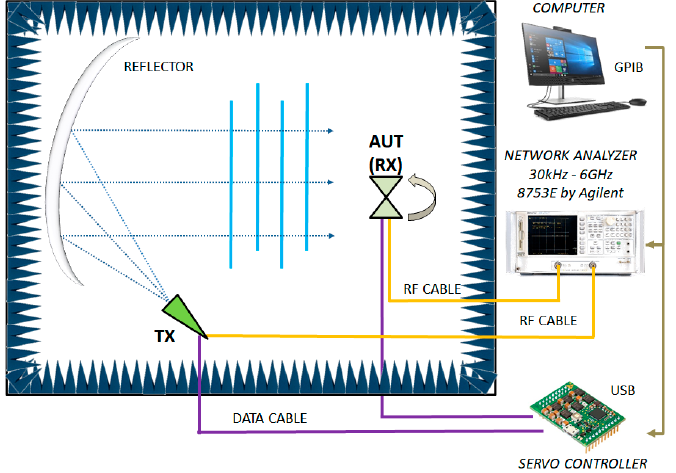
Figure 16. Layout of the anechoic chamber used for the antenna measurement, including intercon- nection details.